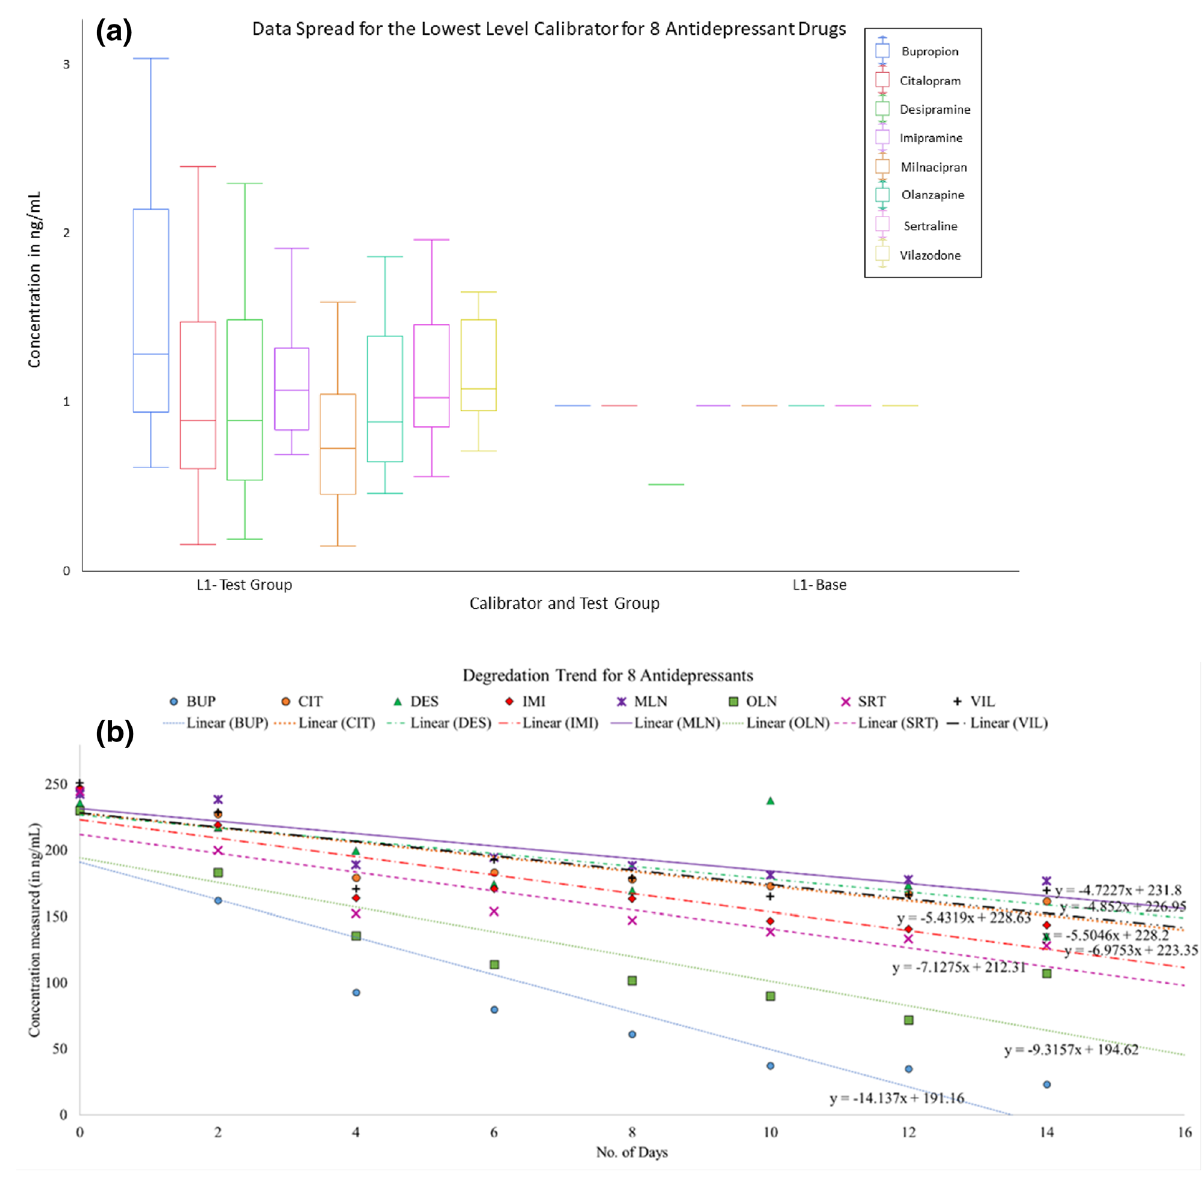
Figure 4. ( a ) Boxplot diagram showing the spread of L1 following L5 injections, and L1-base. Outliers removed; n = 24. ( b ) Average concentration by area of L5 across 14 days and extrapolated trendlines showing analyte degradation (n =